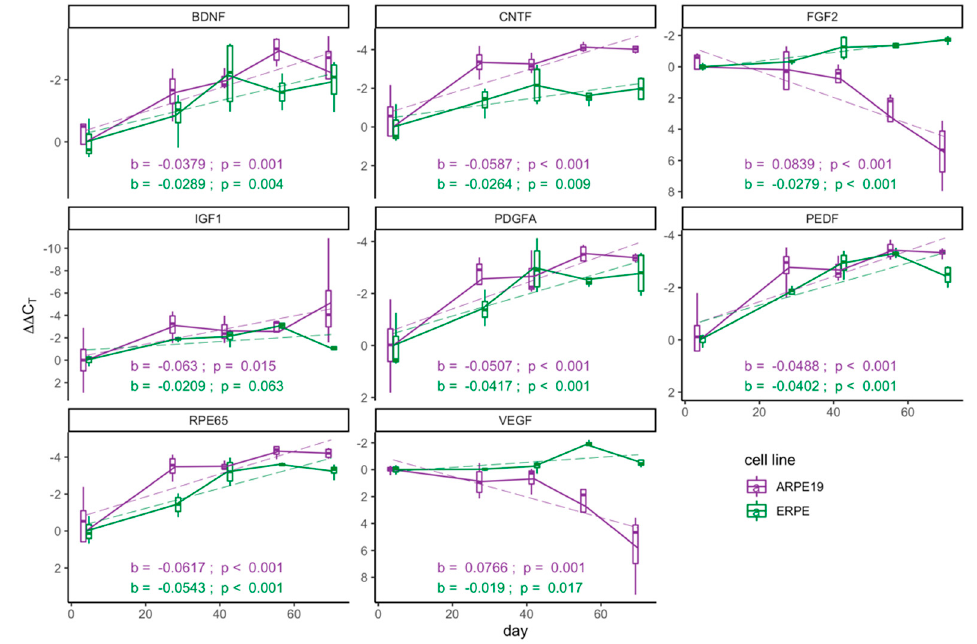
Figure 2. Key functional genes progressively increase with maturation. Real-time polymerase chain reaction (RT-qPCR) analysis of mRNA levels across 70 days of culture in E-RPE culture (green) and ARPE-19 culture (purple). Results were normalized to an endogenous reference gene ( PPIA ) and are presented as ∆∆ Ct means ( n = 4) ± standard deviation at each time point. A linear regression model (dashed line) was used to describe the relationship between ∆∆ Ct values and days of maturation of each gene for both RPE cell sources; regression coefficients, denoted as b, and associated p -values, to reject the null hypothesis that b = 0, are shown on each graph.